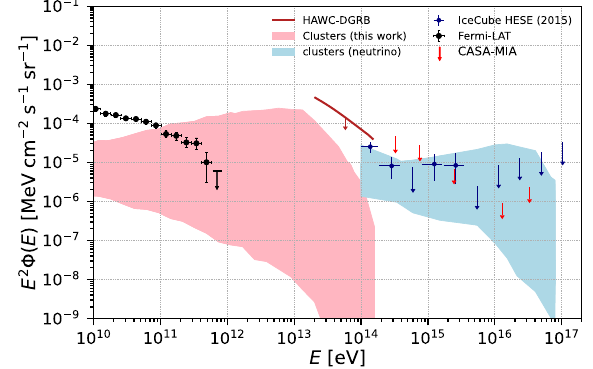
Fig. 6 | Multi-messenger emission from clusters of galaxies. High-energy neu- trinos(blueband)(obtainedby 13 ,errorbarsinIceCubedatacorrespondtothe68% con fi dence intervals 67 ) and gamma rays (pink band) from the entire population of galaxy clusters obtained in this work. The gamma-ray fl ux is compared with the DGRB observed by Fermi-LAT (error bars correspond to the total uncertainties, statisticalandsystematic) 66 ,andtheupperlimitsbyHAWC(95%con fi dencelevel) 31 and CASA-MIA (90% con fi dence level) 32